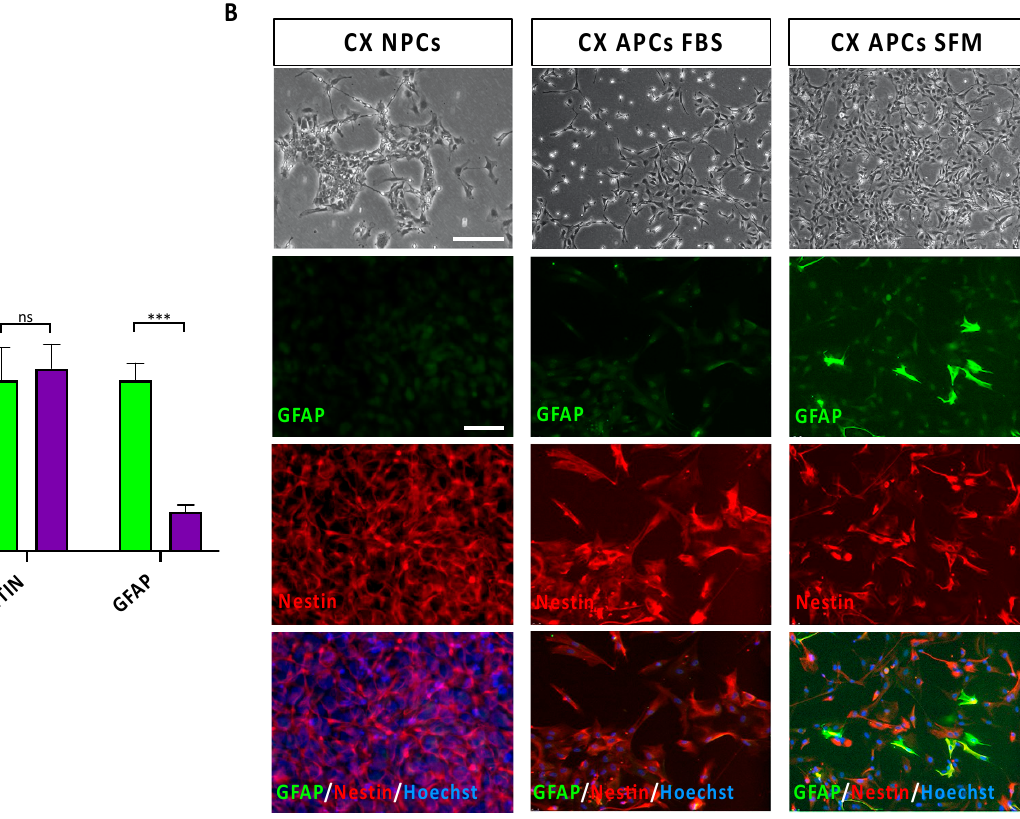
Figure 1. CX hiPSC ‐ derived NPCs were committed to APC identity after DIV 25 of exposure to ACM ‐ SFM or ACM ‐ FBS. ( A ) qPCR analysis for NESTIN, VIMENTIN and GFAP transcript levels in cultures of CX NPCs exposed for DIV 25 to ACM ‐ SFM (green bars) or ACM ‐ FBS (purple bars). Values were normalized to GAPDH and represent the fold ‐ change ratio related to ACM ‐ SFM samples. Data are expressed as means ± STDV ( n = 3 biologically independent experiments). p < 0.001 (***) and not significant (ns) according to Student’s t ‐ test analysis. ( B ) Representative phase contrast and immunofluorescence pictures of the starting (DIV 0) CX NPCs and the resulting CX APCs at DIV 25 of exposure to ACM ‐ SFM or ACM ‐ FBS conditions. The fluorescence images are related to the GFAP and Nestin markers and the superimposition of these are shown. Nuclei are stained with Hoechst. Scale bar: 100 μ m.